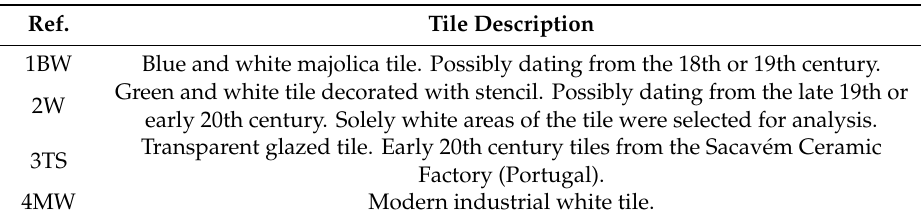
Table 1. Description of the tile samples selected for the